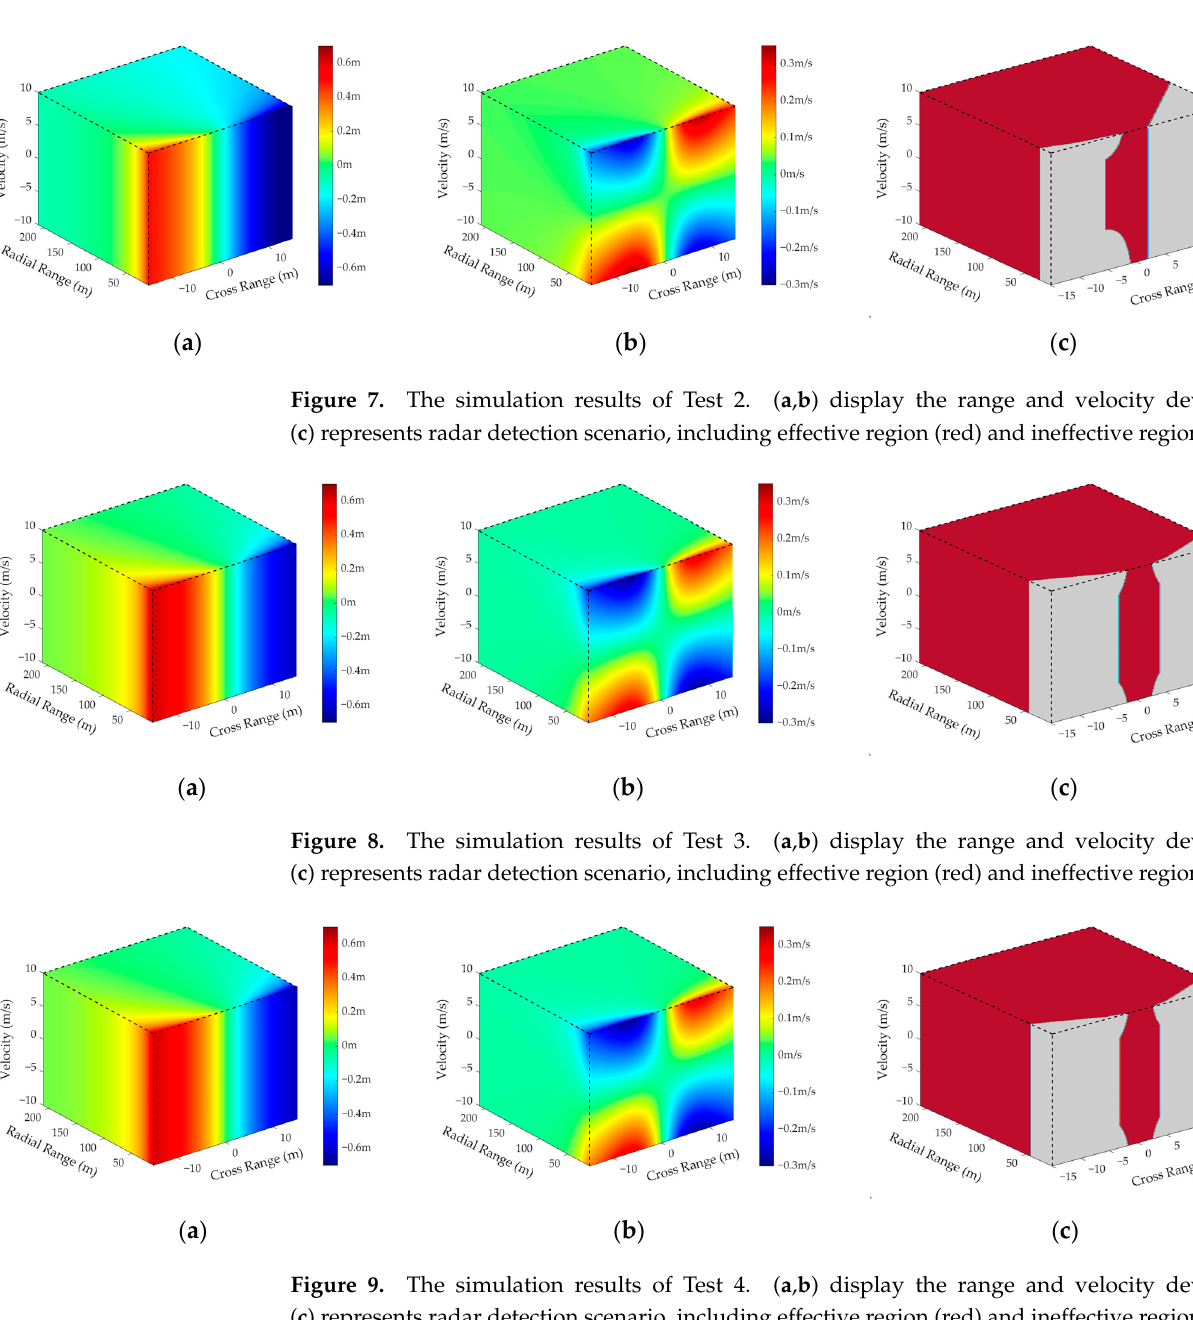
Figure 6. The simulation results of Test 1. ( a , b ) display the range and velocity deviations. ( c ) represents radar detection scenario, including effective region (red) and ineffective region (gray).